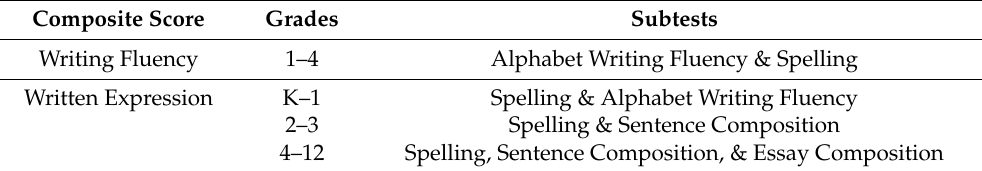
Text Generation Text Writing Fluency Writing Quality Adapted from Breaux (2020, p. 95). a Part of oral language domain. Table 5. WIAT-4 Writing Composite Scores. Composite Score Grades Subtests Writing